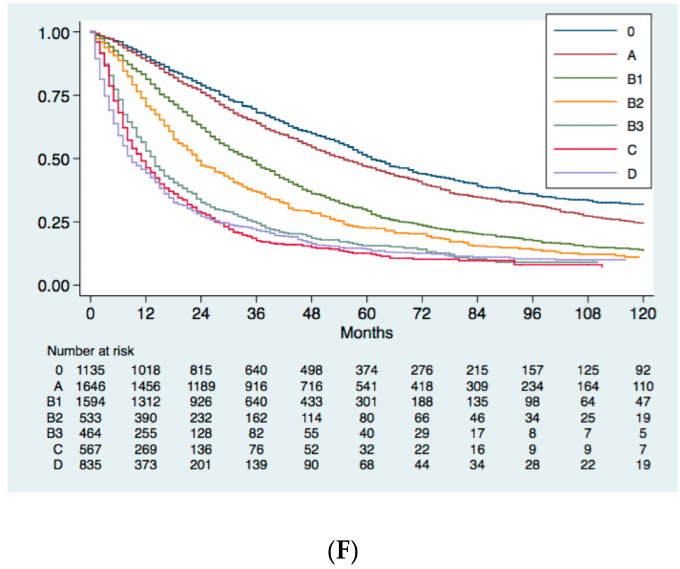
Figure 2. Kaplan-Meier survival curve of the study group stratified according to CLIP ( A ) and MESH ( B ) scores, BCLC ( C ) and CNLC ( D ) stages, ITA.LI.CA score ( E ) and ITA.LI.CA simplified staging ( F ). Log-rank test was always p < 0.001.